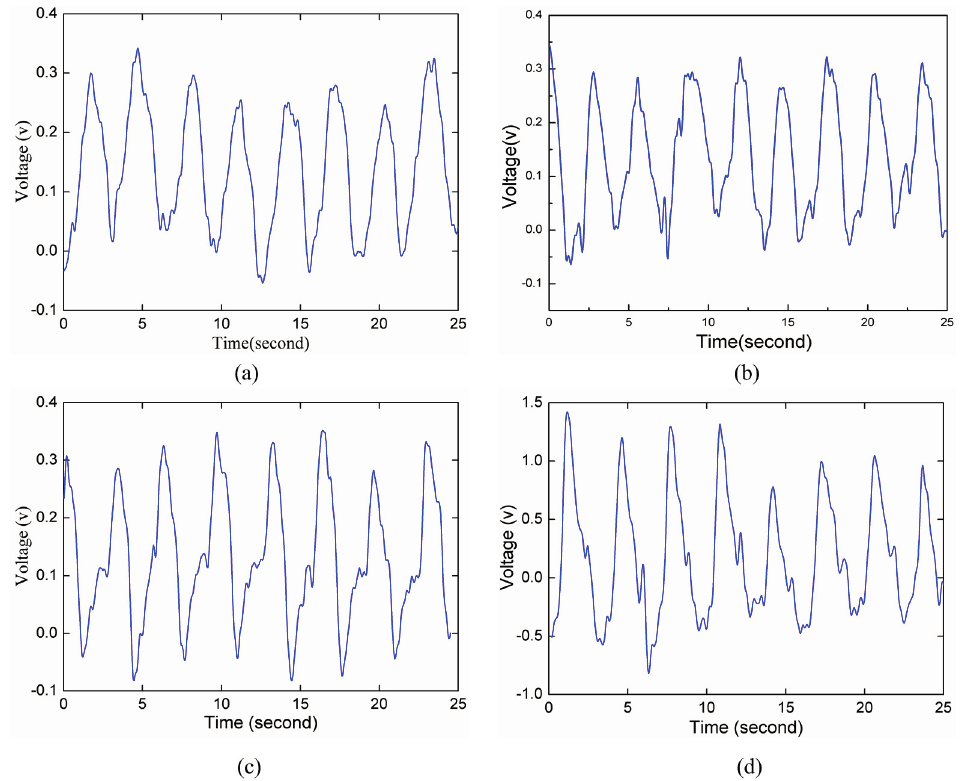
Figure 8. Respiration waveforms detected at different human body postures. ( a ) Lying on his back; ( b ) Lying on his stomach; ( c ) Lying on his side with the back towards the radar; ( d ) Lying on his side and facing towards the